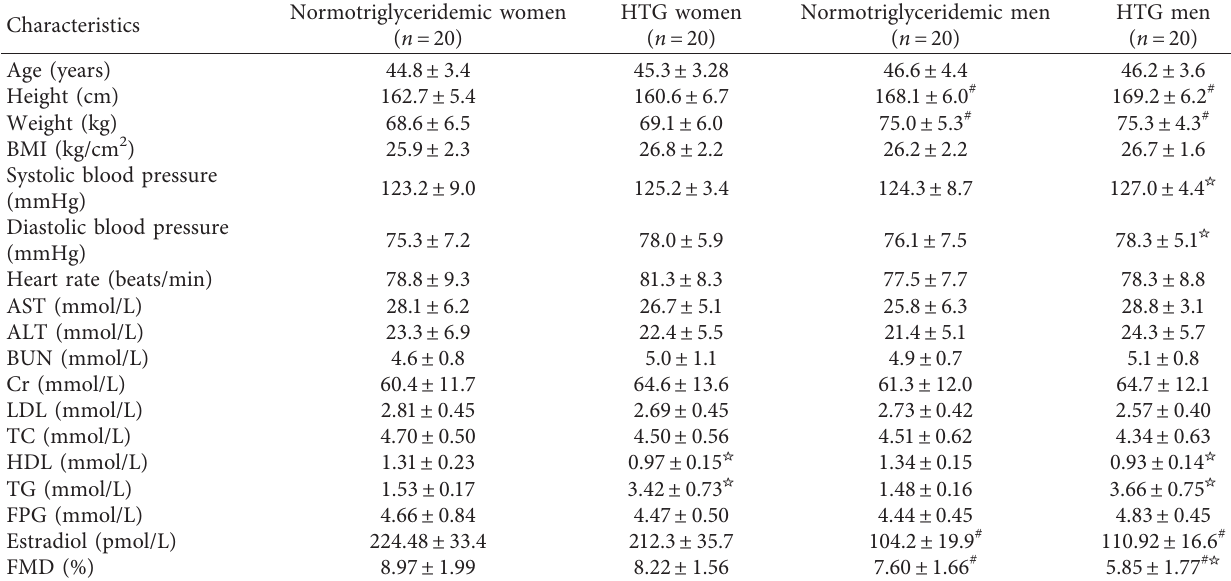
Table 1: Clinical and biochemical